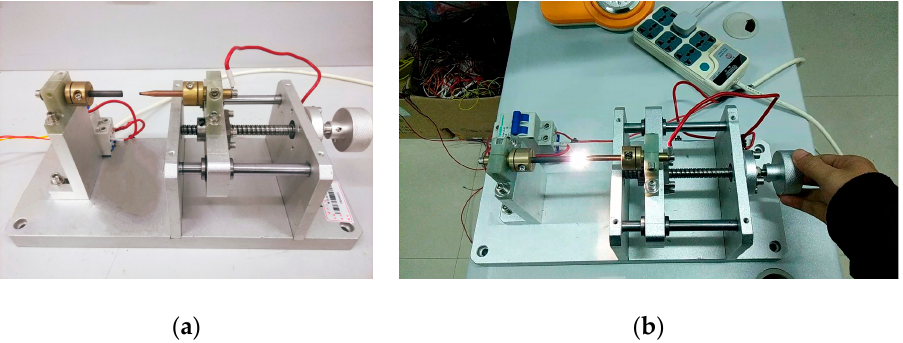
Figure 19. Arc generator. ( a ) Disconnected arc generator; ( b ) arc generator and its arc.